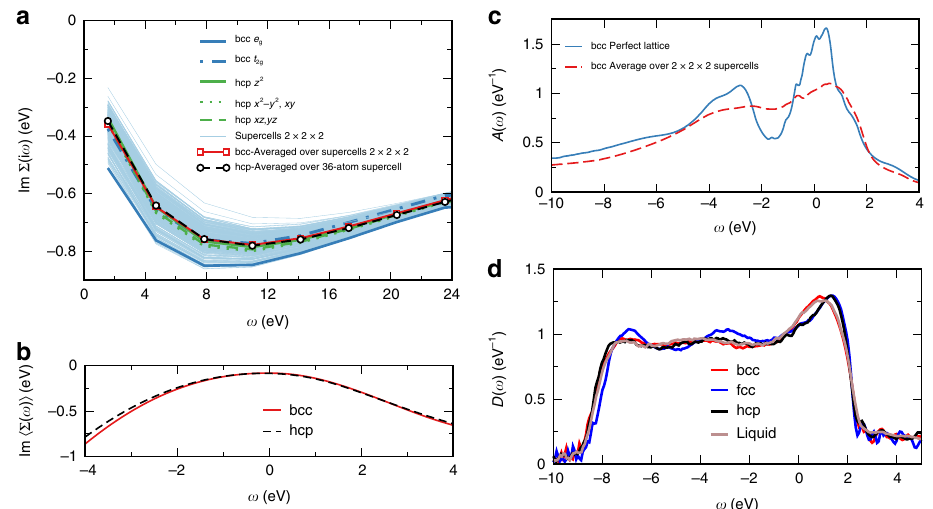
Fig. 2 Electronic self-energy and electronic structure of iron at Earth ’ s inner-core conditions. a The imaginary part of dynamical mean- fi eld-theory (DMFT) self-energy on the Matusbara grid for different atomic sites and orbitals of the set of 2 × 2 × 2 body-centered cubic (bcc) supercells (thin light-blue curves). The average over all sites and orbitals of bcc supercell self-energy 〈 Σ 〉 (thick red line with squares) and the average self-energy over sites and orbitals of the hexagonal close-packed (hcp) 36-atom supercells (black line with circles) are also shown. The blue and green curves are the self-energies for the nondegenerate orbitals in the perfect bcc and hcp lattices, respectively. b The average DMFT bcc (red) and hcp (dashed black) self-energy in real frequency. c The DMFT spectral function for the Fe 3 d states averaged over all sites in the set of 2 × 2 × 2 bcc supercells (red dashed line) compared to that for the perfect bcc lattice (solid blue line). d The density-functional-theory (DFT) densities of states of the bcc, face-centered cubic, hcp, and liquid iron at